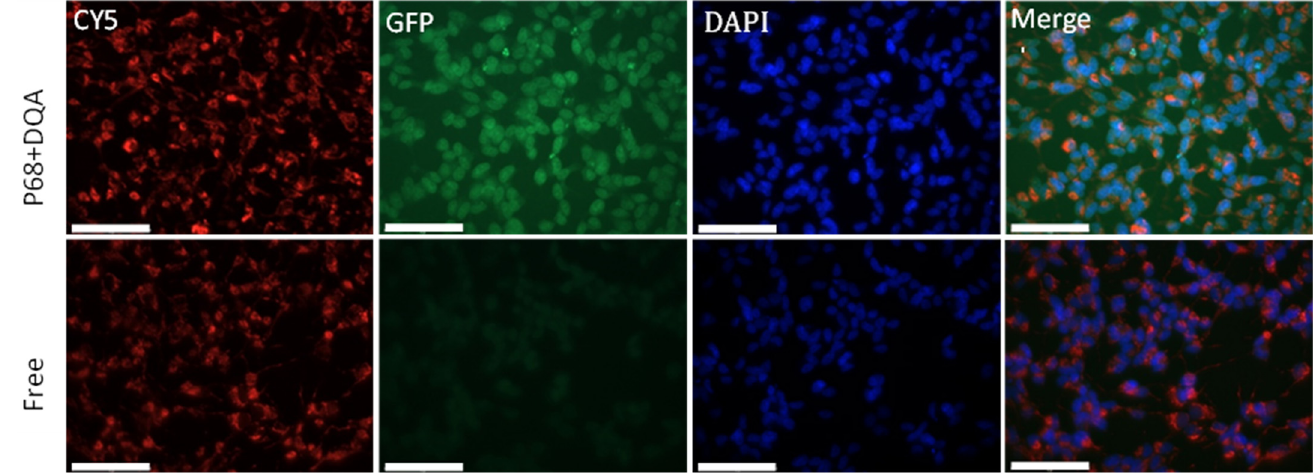
Figure 6. Mitochondrial targeting with P68 + DQA 10 µ M curcumin compared to free 10 µ M curcumin in SH-SY5Y cells following passage across the hCMEC/D3 Transwell ® model. Mitotracker™-stained mitochondria are shown in red (Cy5 objective), internalised curcumin is shown in green (GFP objective); stained nuclei are shown in blue (DAPI objective) and orange indicates the overlap of curcumin and mitochondrial fluorescence (merged image). Scale bars = 75 μ m.